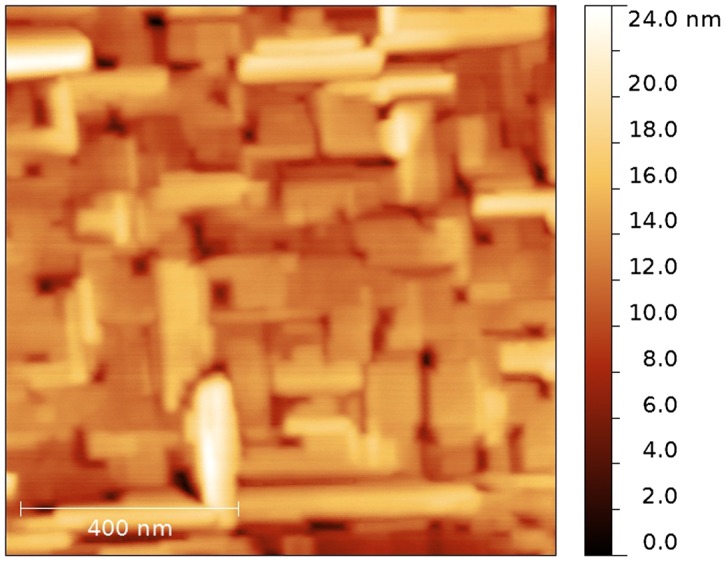
AFM image of a 200-nm thick LaF3 film.